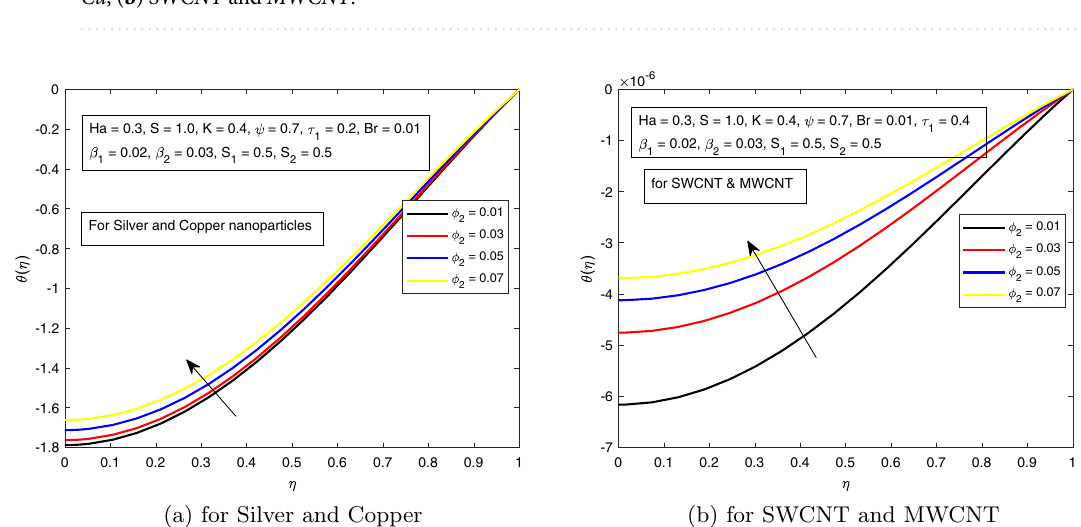
Figure 11. Influence of φ 2 on temperature distribution θ( r ) for the hybrid nanofluid combination of ( a ). Ag and Cu , ( b ) SWCNT and MWCNT .